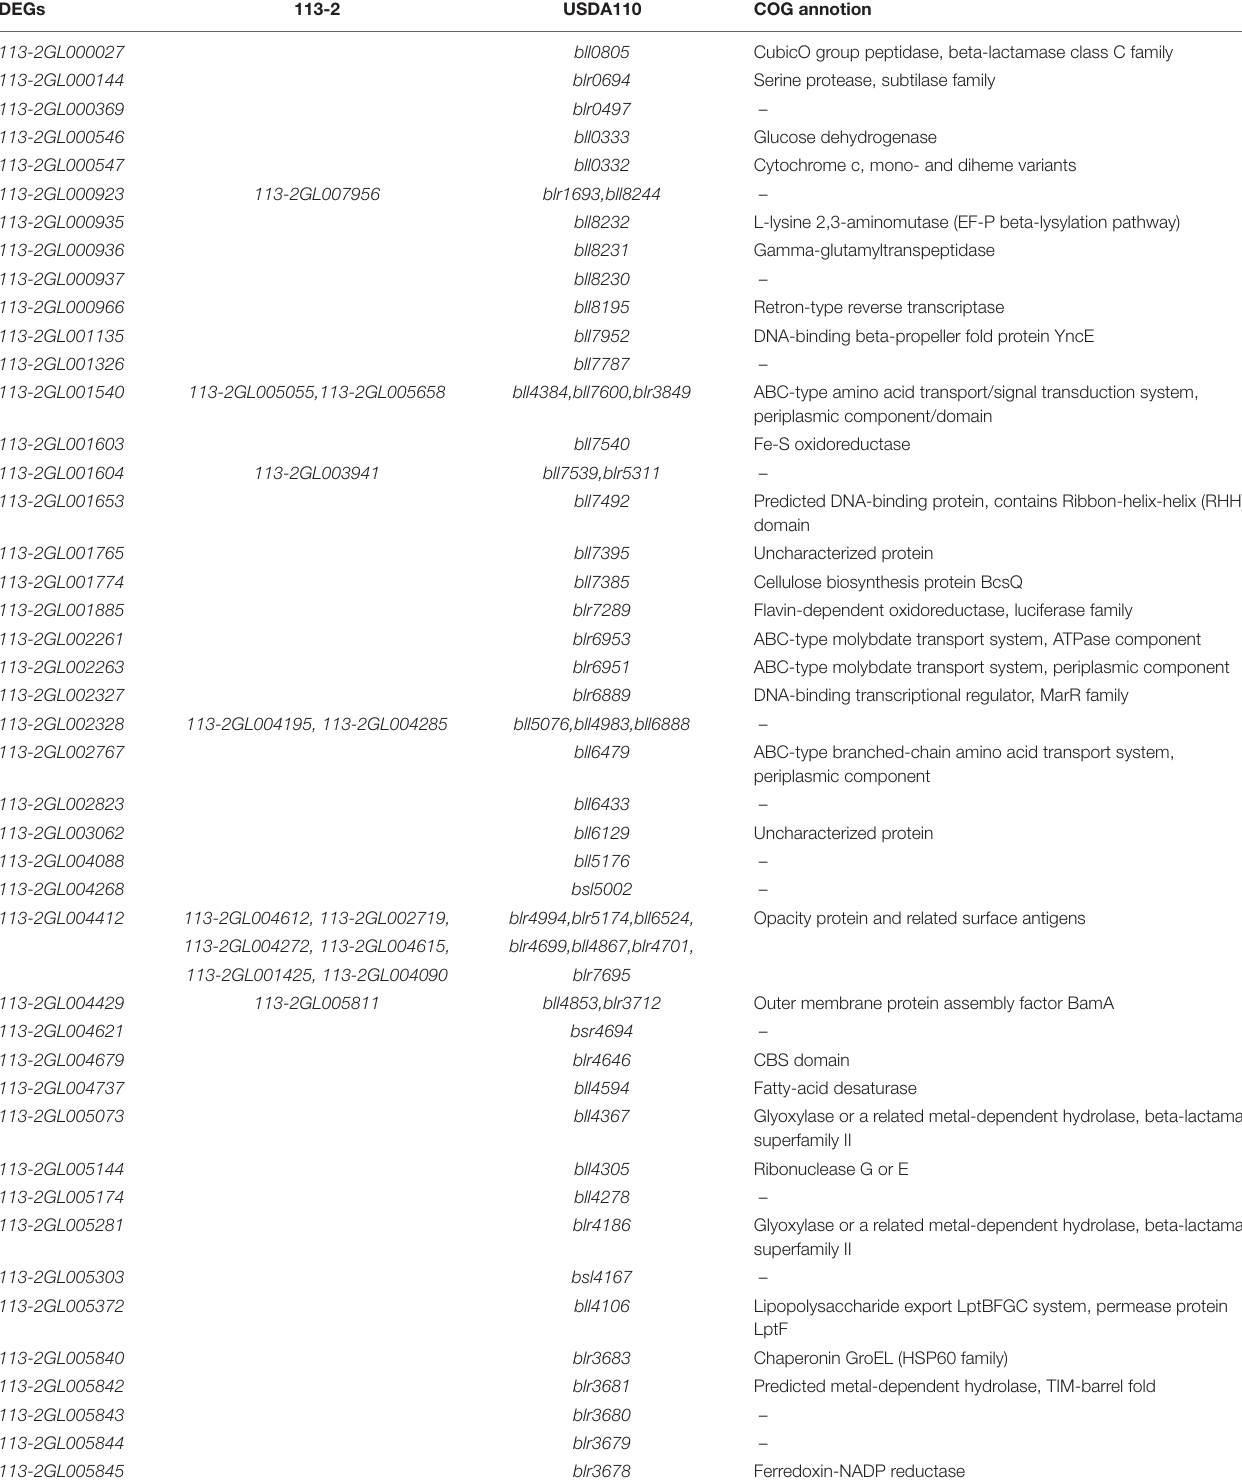
TABLE 2 | Analysis of species-specific or host specific